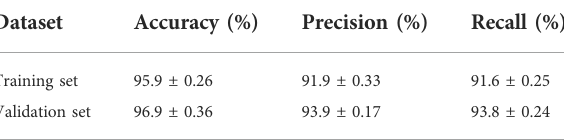
TABLE 2 Training and validation set performance over 300 epochs for our model.